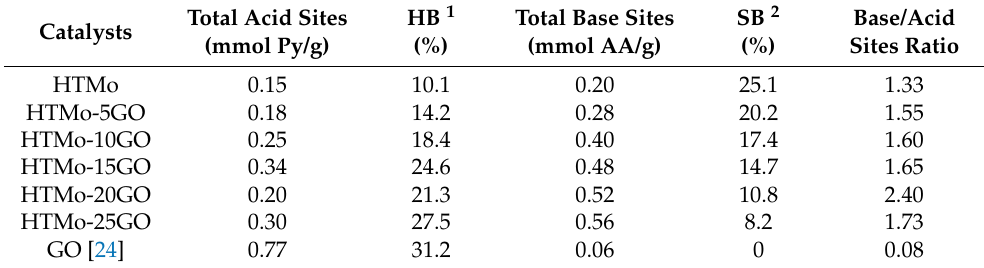
Table 2. Distribution of acid and base sites in the samples.